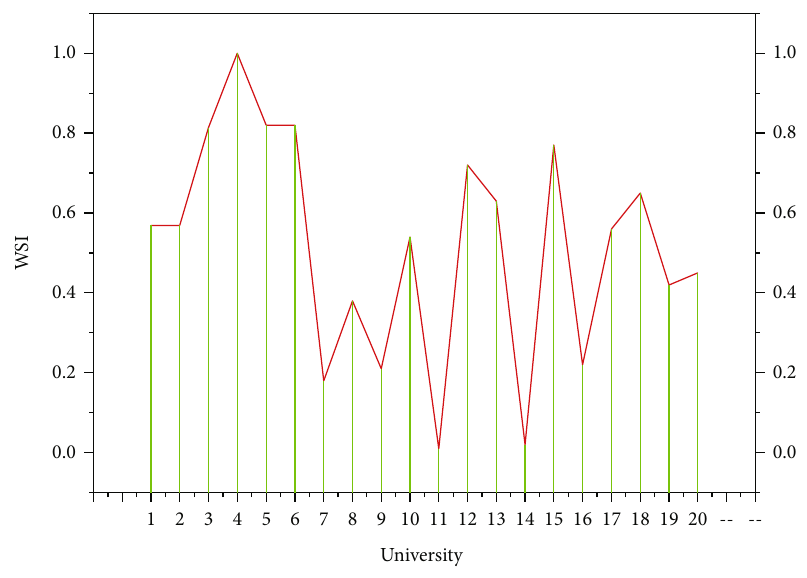
Figure 9: The standardized results of